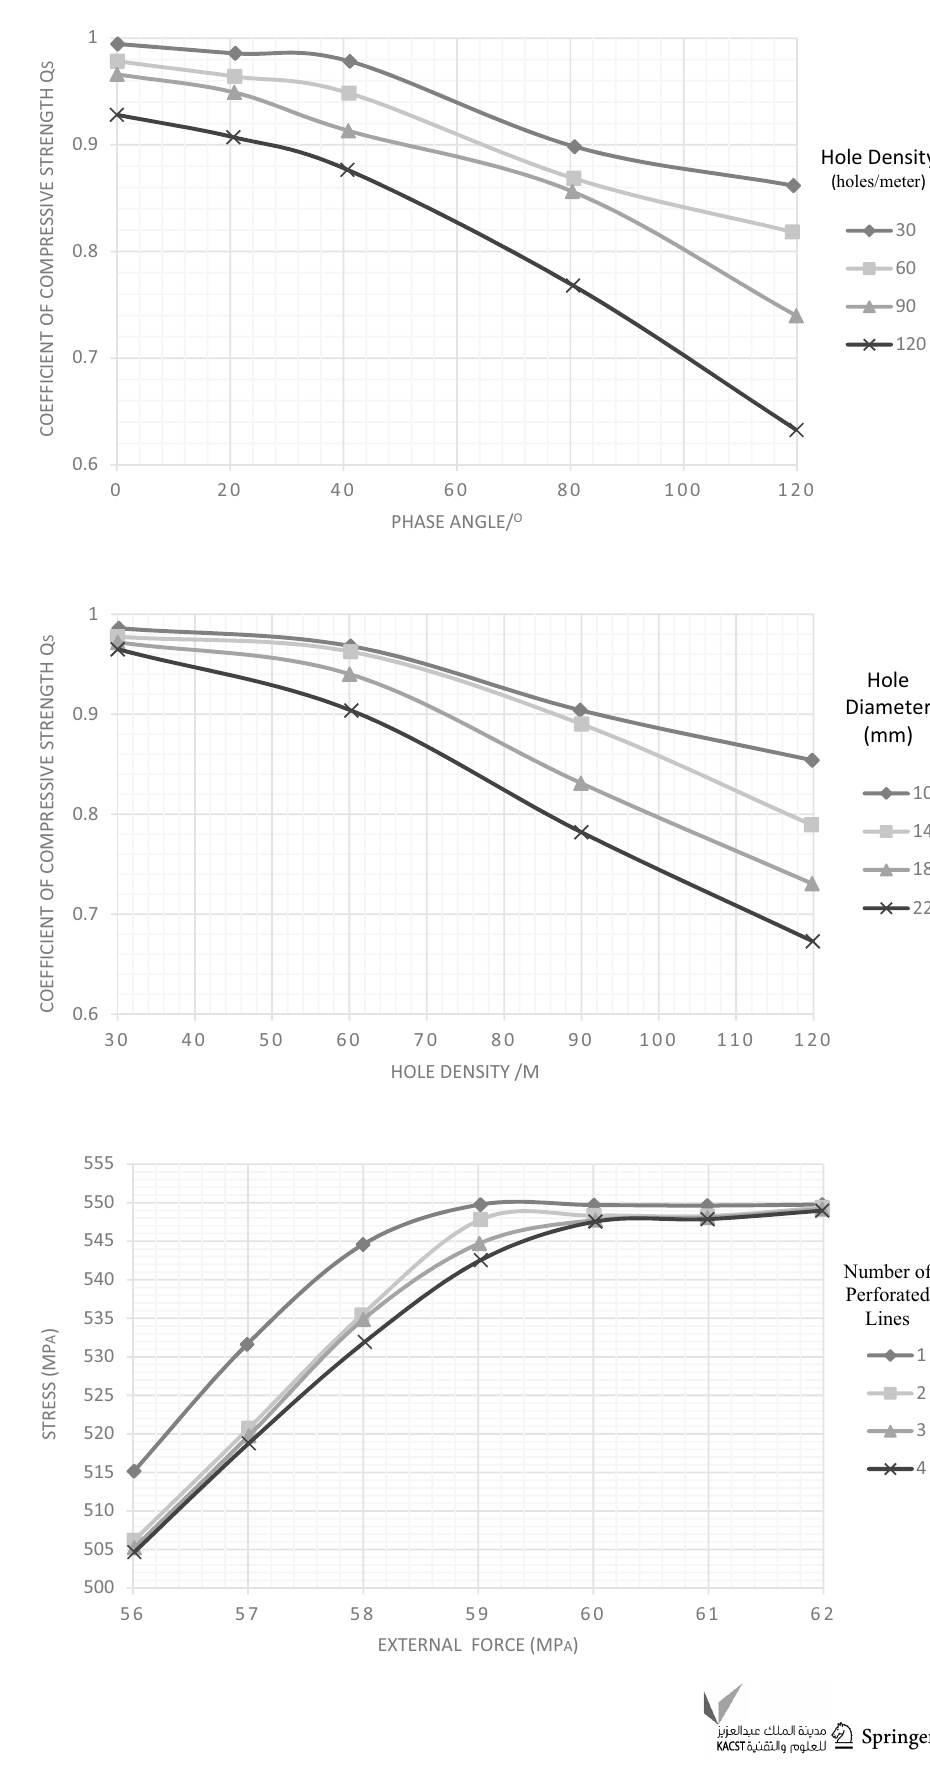
Fig. 8 Influence of hole density on collapse resistance strength at different phases